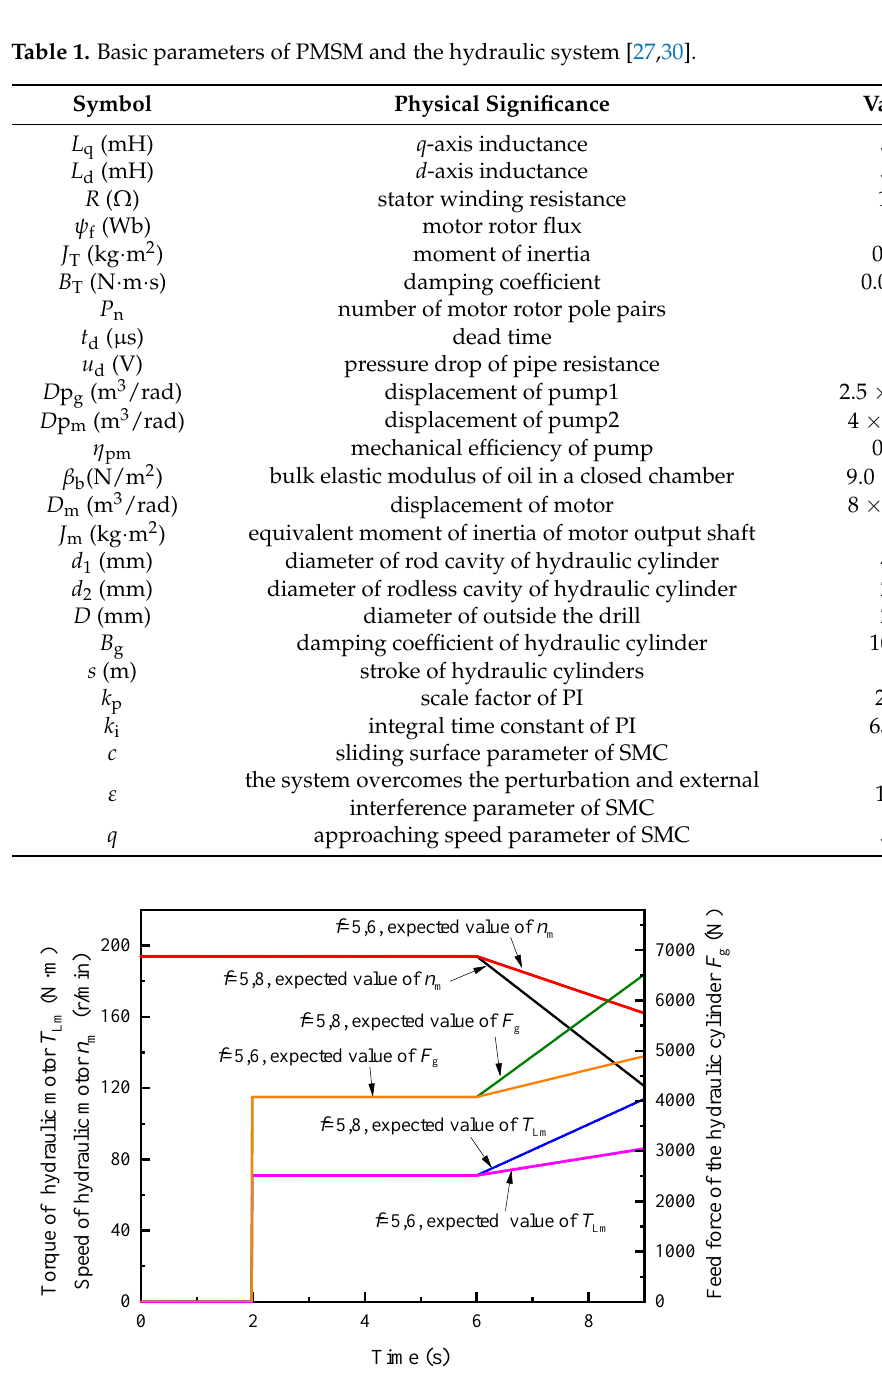
Figure 5. Analogue simulation input curve.